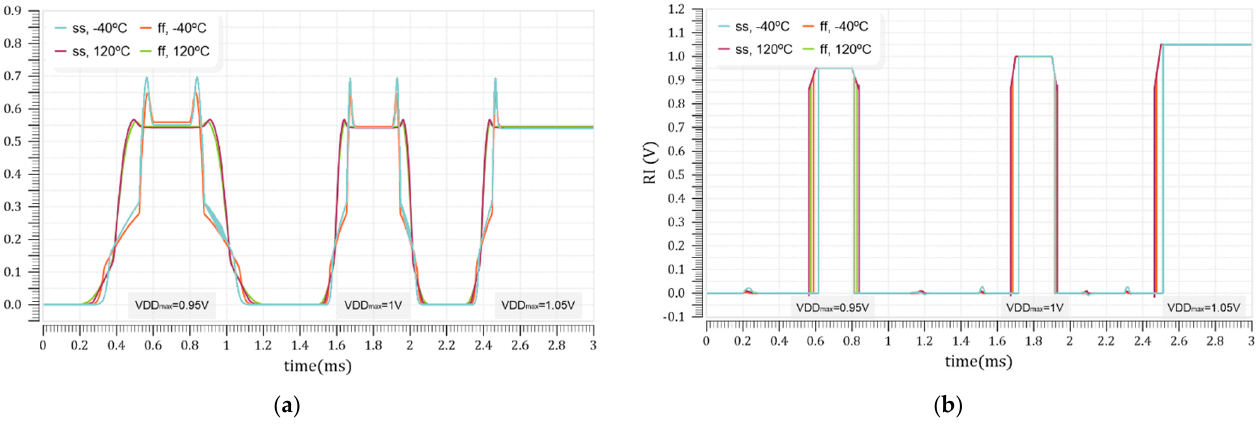
Figure 7. Simulation results for BGR#1 (65 nm, 1 V) in typical temperature (27 °C), 1 V supply volt- age, ±10%. and +120 ◦ C.